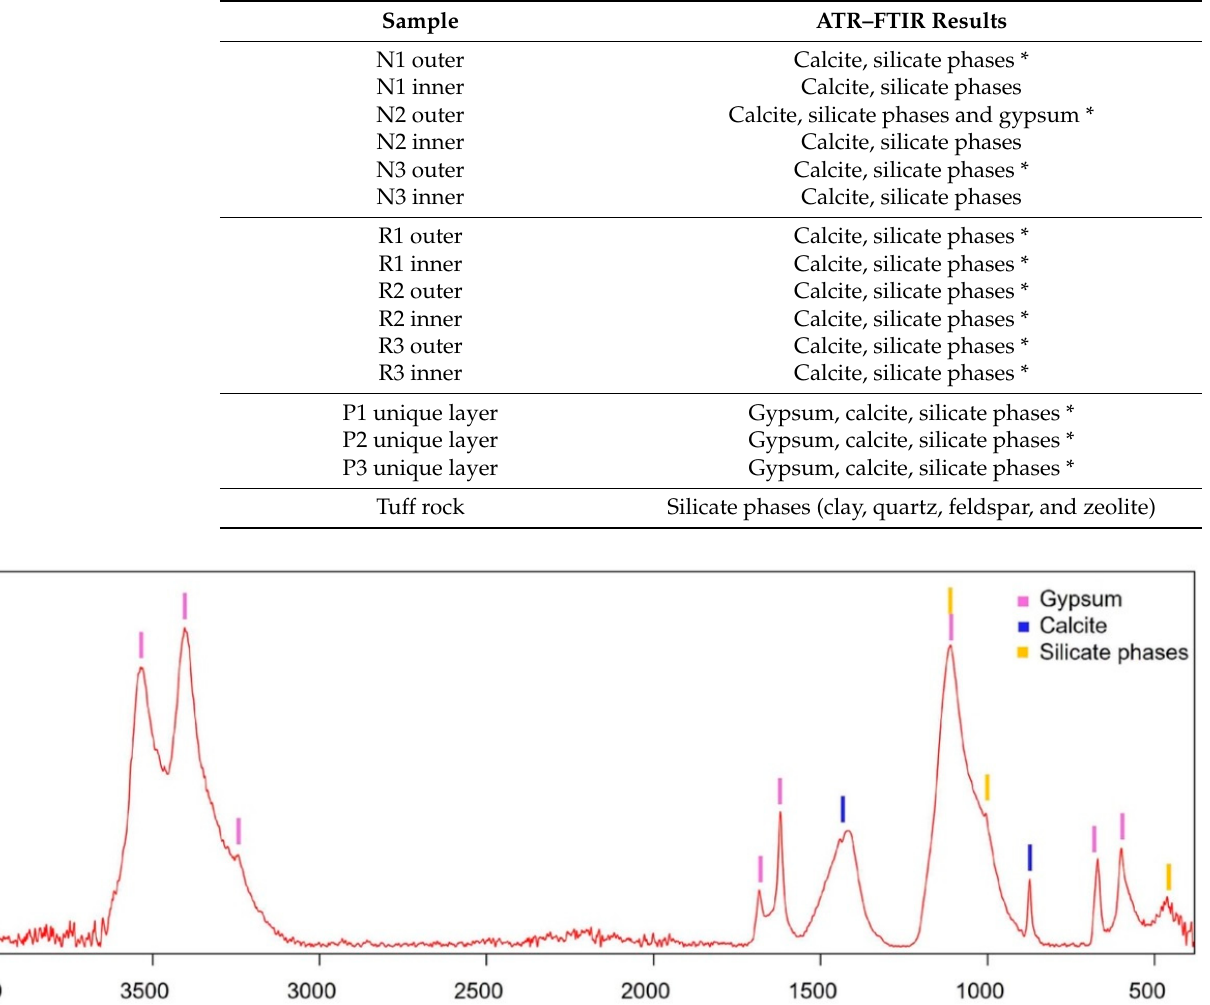
Table 3. Results of the ATR–FTIR analysis of the preparatory samples. * represents weak peaks.